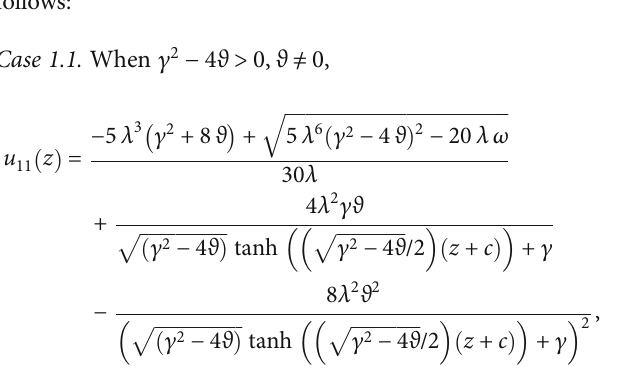
p ffiffiffiffiffiffiffiffiffiffiffiffiffiffi 4 ϑ − γ 2 ffiffiffiffiffiffiffiffiffiffiffiffiffiffi 4 ϑ − γ 2